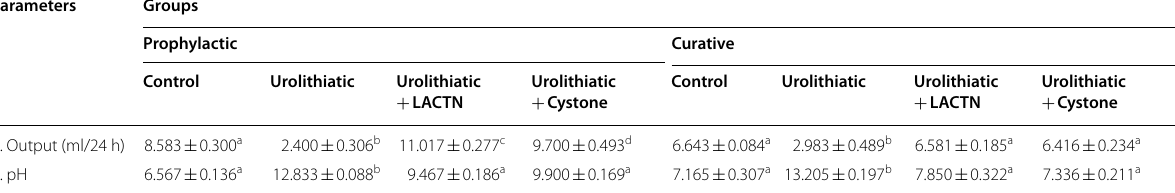
Table 3 Effect of polyherbal formula (LACTN) on urinary output and pH of urolithiatic rats Parameters Groups